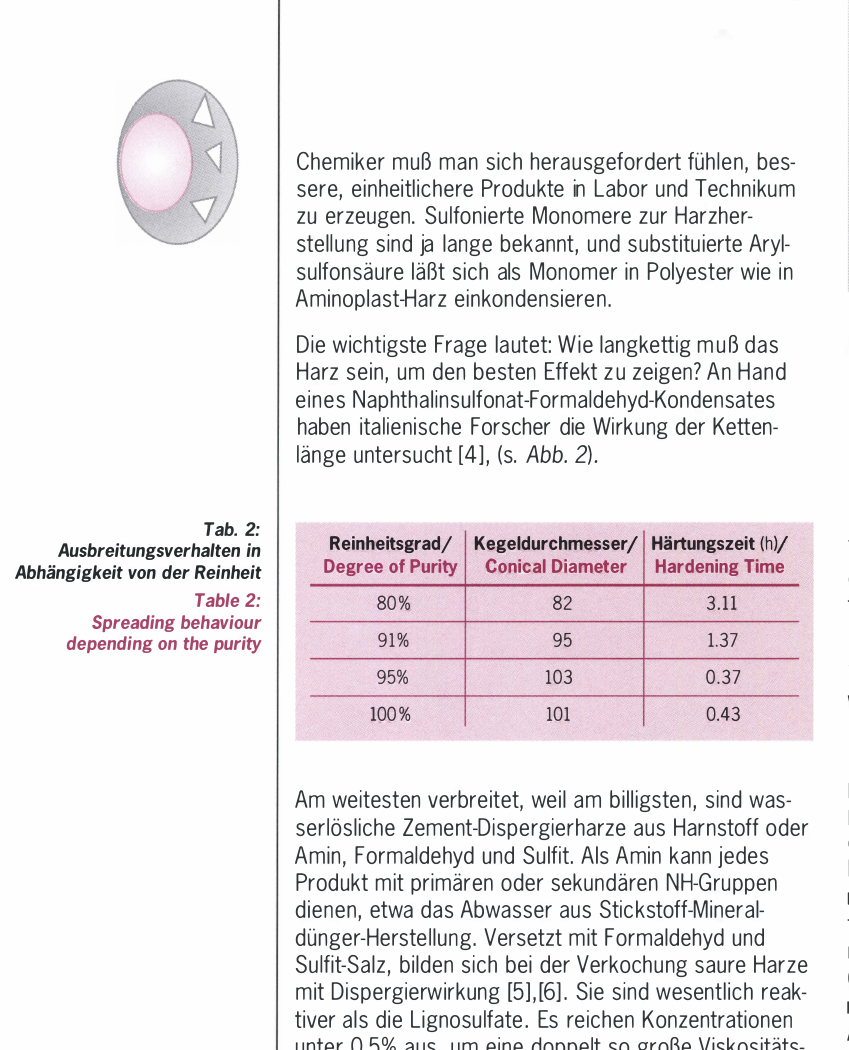
Tab. 3: EinfluB von Co-Monomer auf die Verfliissigerwirkung von Poly-(Butadiensulfonat) Table 3: Influence of co-monomers on the liquefying effect of poly­ (butadiene sulphonate)